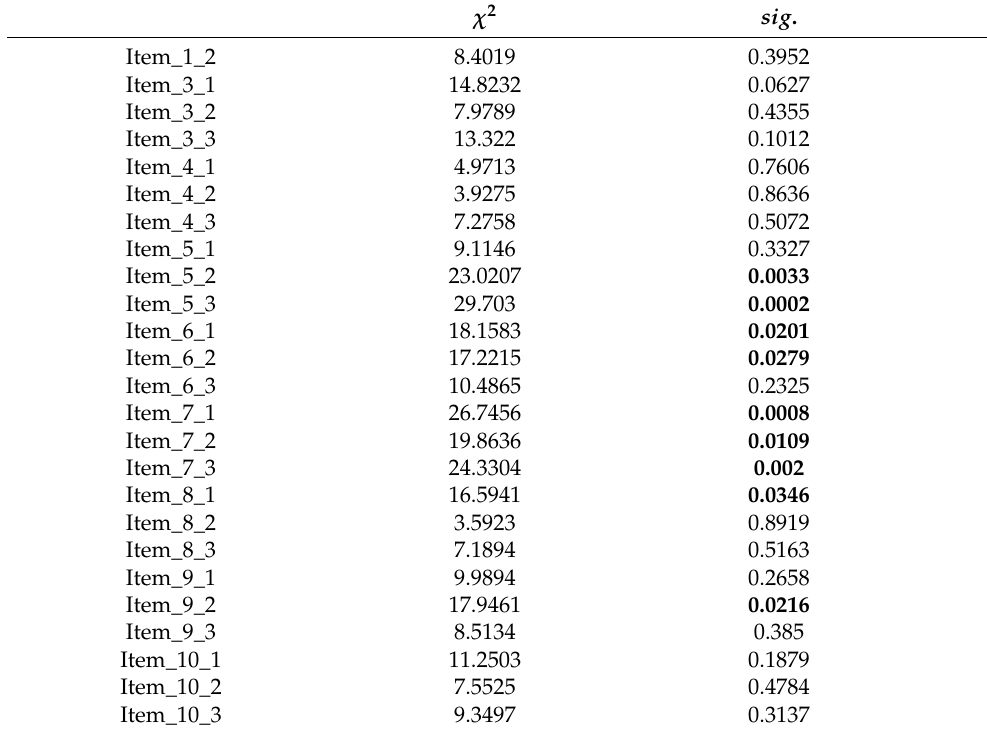
Table 3. Item fit for the 25 Tower of London tasks. Significant p -values are marked with bold. χ 2 sig .